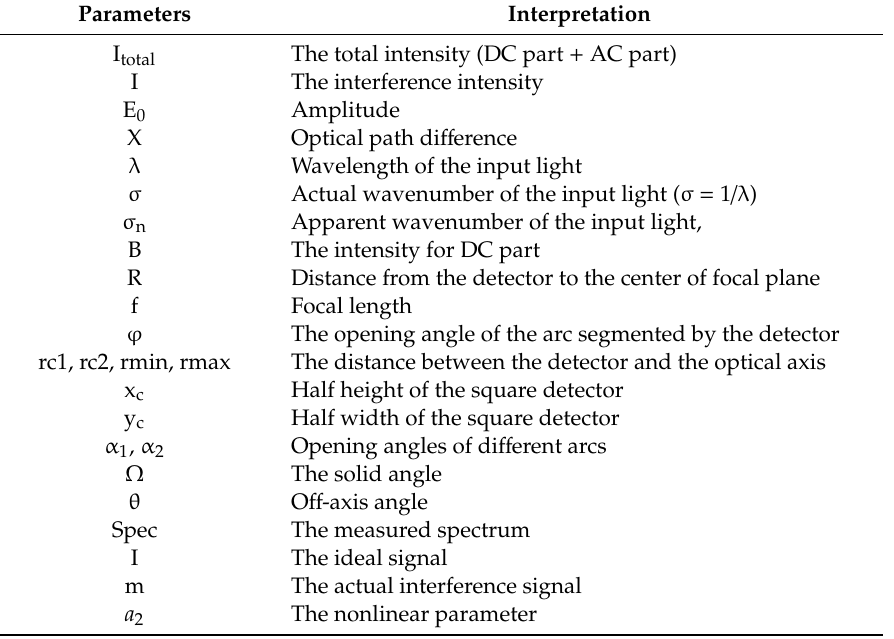
Table 1. Explanation of parameters in the equations in this